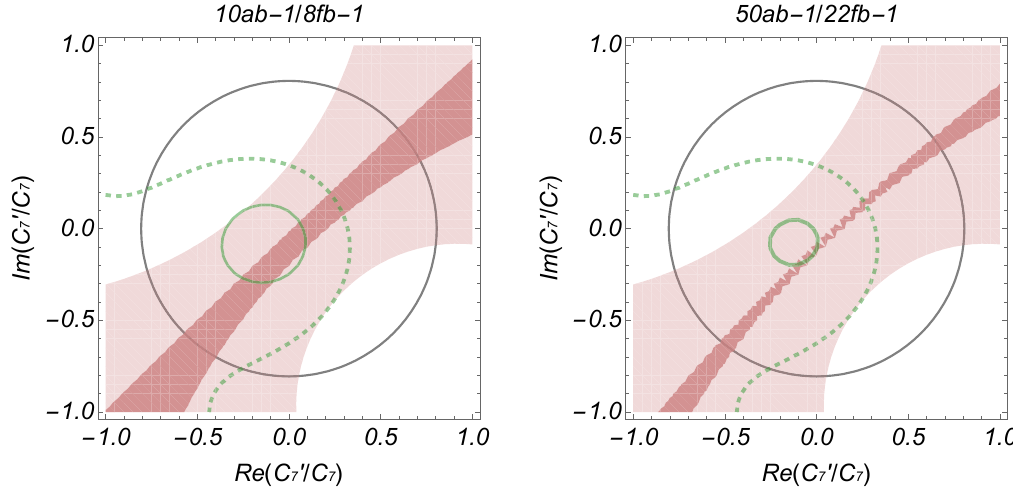
- 1.0 1.0 0.5 0.0 0.5 1.0 - - - Figure 4 . Constraints on Re ( C ) and Im ( C ) at the three standard-deviations level. The (cid:31) 7 /C 7 (cid:31) 7 /C 7 light red region is the constraint obtained from the current measurement of time-dependent CP = 0 . 15 0 . 20 [26], overlaid with the constraint asymmetry in B 0 π 0 K 0 γ decays, S → S π 0 K 0 S γ − ± (dark red) obtained from the expected precision at Belle II with integrated luminosities of 10 ab − 1 (left) and 50 ab − 1 (right). The dashed green contour is the constraint obtained from the angular 0, measured by LHCb [14], A (2) = 0 . 23 0 . 24 coefficients of B K ∗ e + e − decays at q 2 T → − ± → = 0 . 14 0 . 23, overlaid with the contraint (full green line) obtained from the expected and A im T ± 1 ) and Run III (22 fb 1 ). The grey circular contour is the con- precision at LHCb Run II (8 fb − − straint obtained from the branching fraction measurement of the inclusive B X s γ processes with → ( B X s γ ) E γ > 1 . 6GeV B →